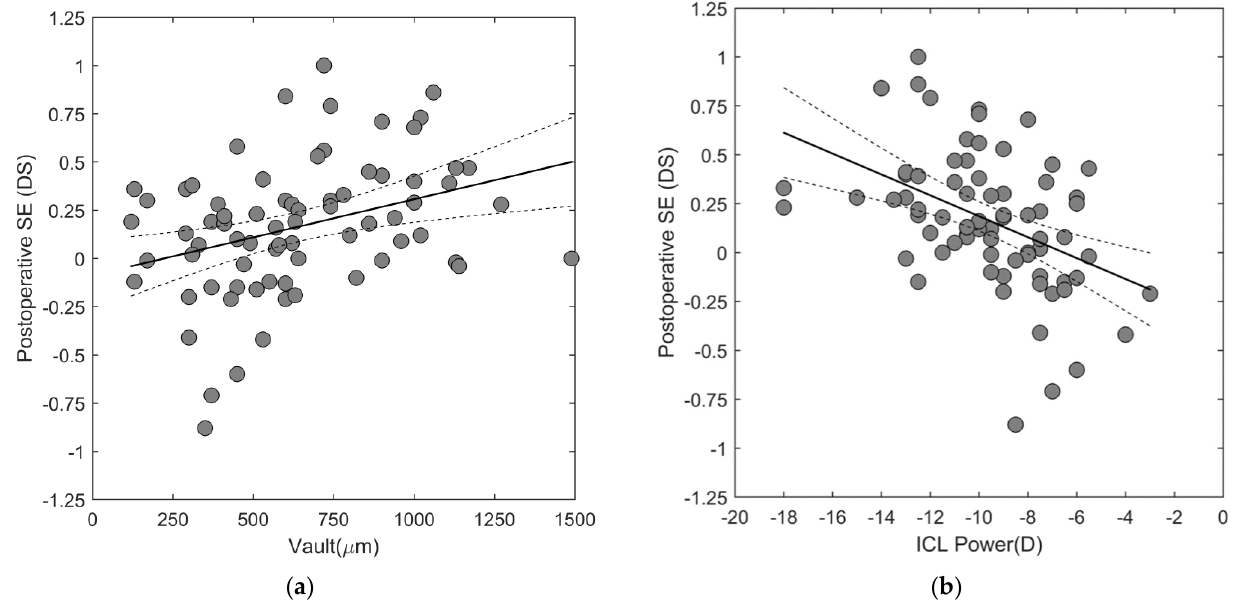
Figure 4. Association between the postoperative SE and ( a ) vault, and ( b ) ICL power. The continuous line represents the linear model fit to the data and the dashed lines represent the 95% confidence intervals limit. Postoperative SE = postoperative manifest SE - postoperative predicted SE.